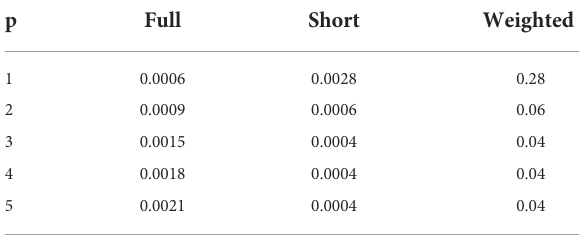
TABLE 1 Different error metrics comparing homomeric K v channel models with different gate numbers. p